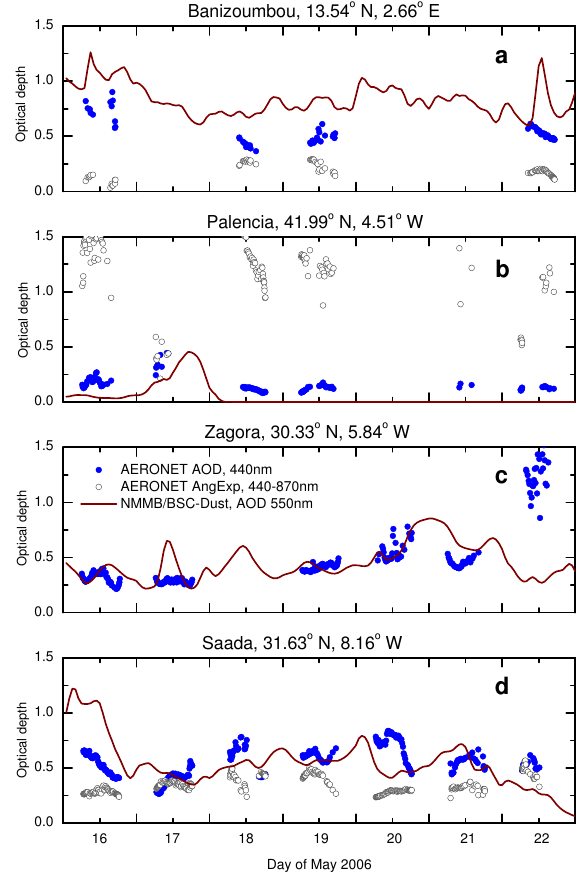
Fig. 9. The same as in Fig. 8, but at Banizoumbou (a) , Palencia (b) , Zagora (c) , and Saada (d)